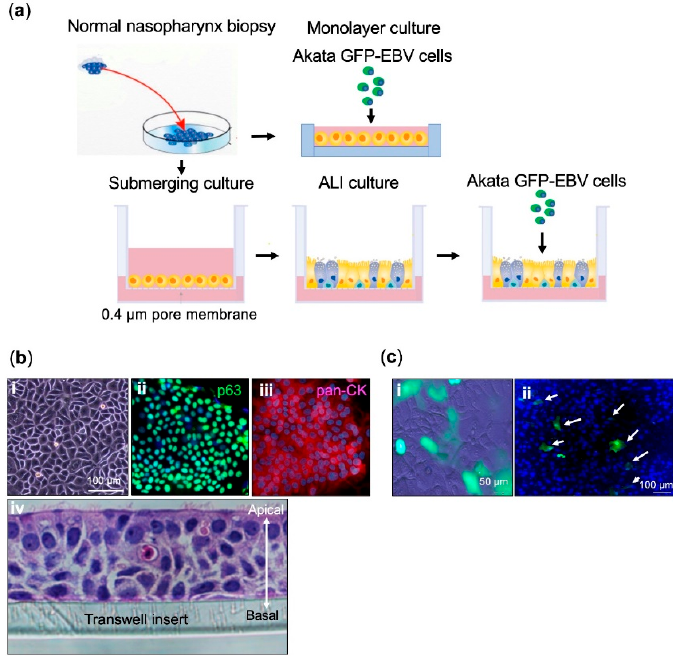
Figure 1. An in vitro Epstein–Barr virus (EBV) infection model of pseudostratified epithelium derived from primary nasopharyngeal epithelial cell cultures: ( a ) diagram of the experimental procedure.